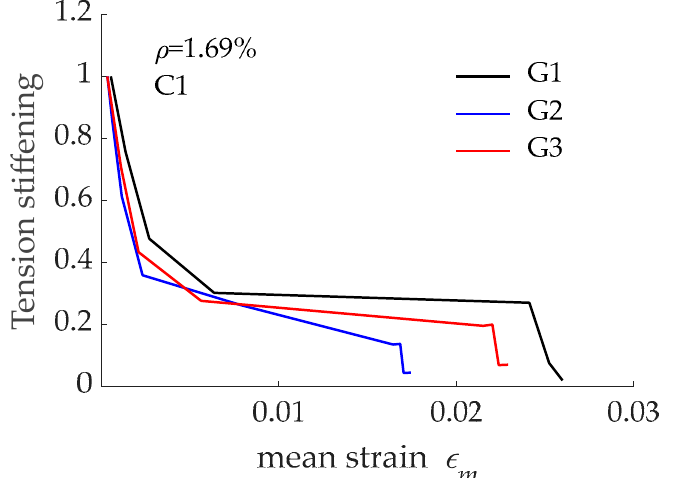
Figure 9. Effect of GFRP reinforcing bar bond performance on the tension stiffening effect in concrete C1.